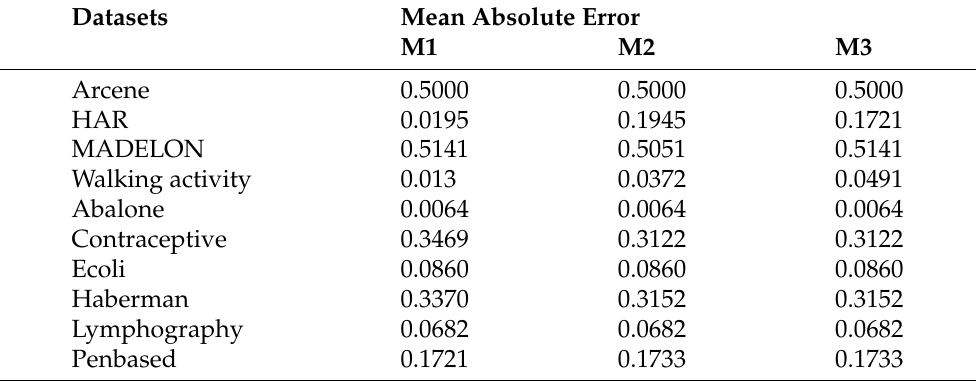
Table 8. Mean absolute error of the proposed work with SVM